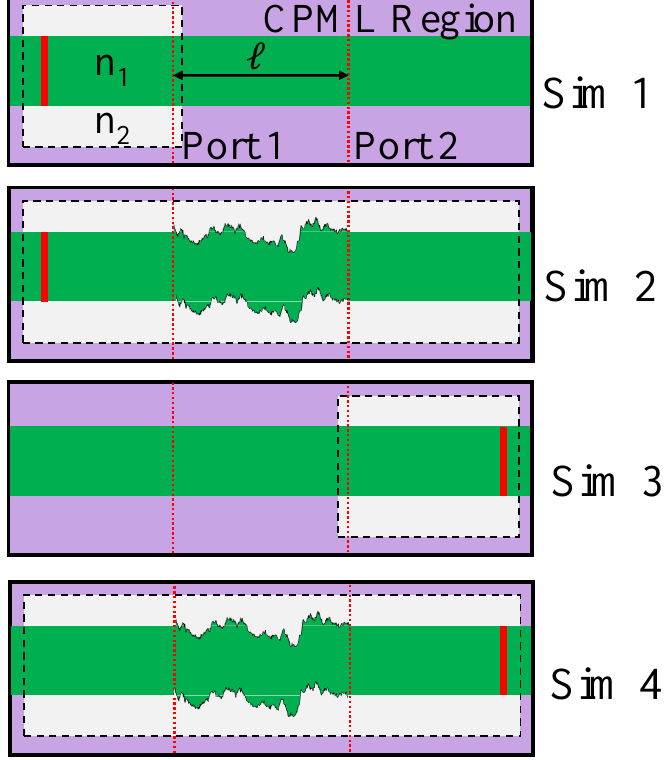
Figure 4. Four-step simulation setup for S-parameters extraction